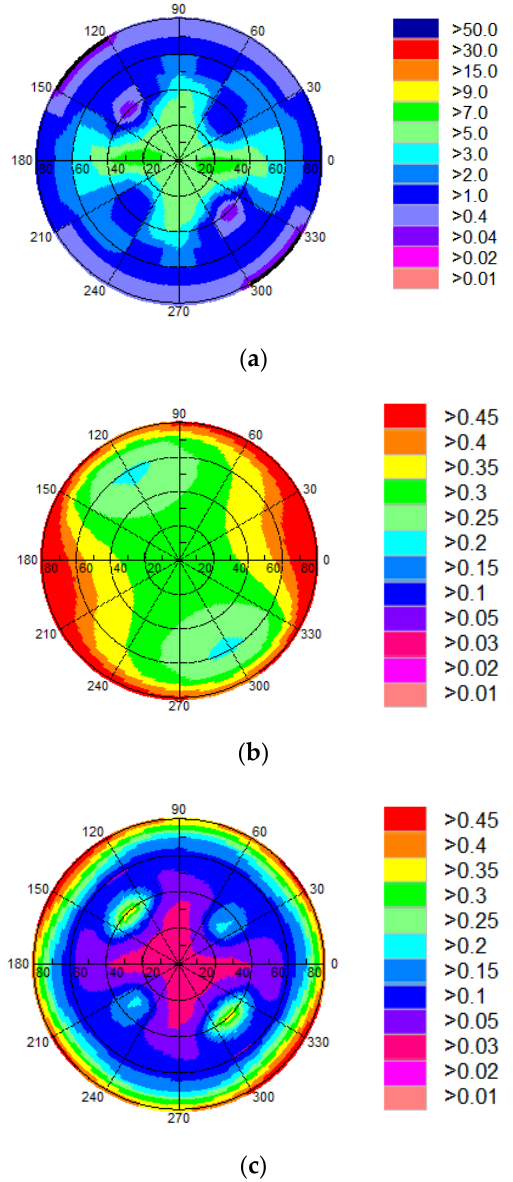
Figure 8. (Color online) Calculated performance of ORW e-paper. ( a ) Angular characteristics of the contrast ratio. Angular characteristics of the reflectance coefficient for ( b ) bright and ( c ) dark